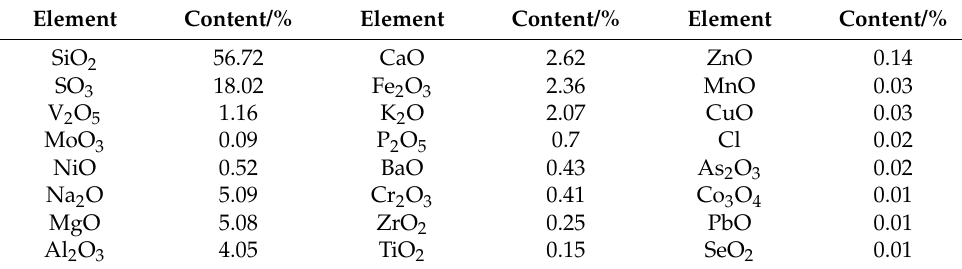
Table 1. X-ray fluorescence semi-quantitative analysis